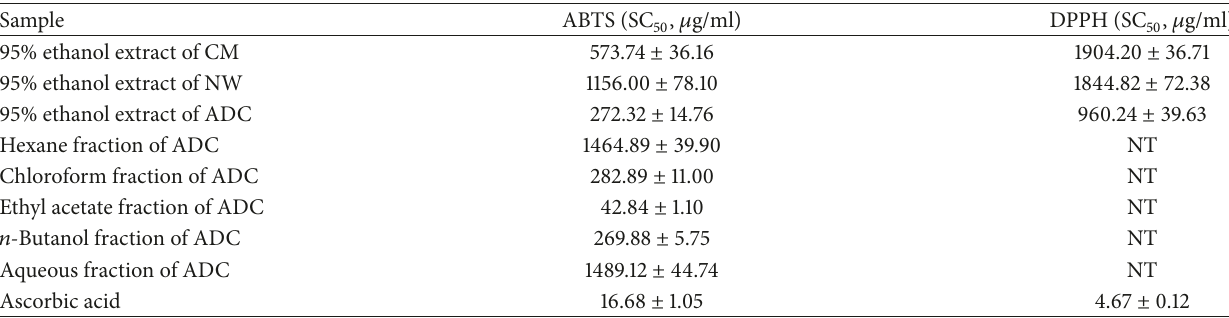
Table 1: Antioxidant activities of the extracts and